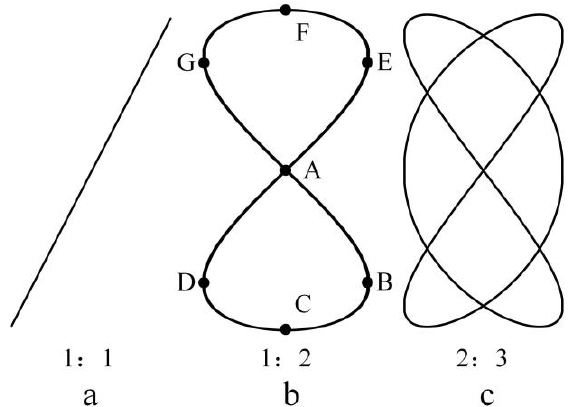
Figure 4. Movement track of blades at different frequency ratios. ( a – c ) represent the motion trajectory of the point on the blade when the frequency ratio is 1:1, 1:2 and 1:3 respectively.